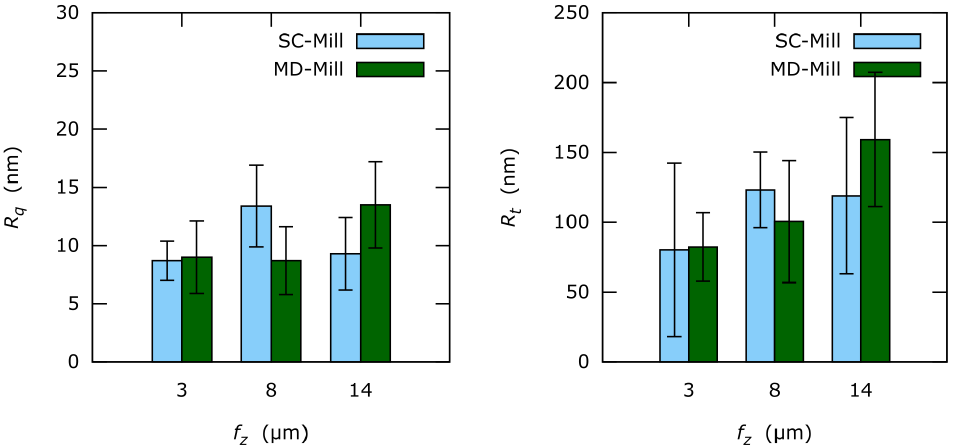
Figure 11. Vertical one-dimensional roughness R q and R t of the analyzed